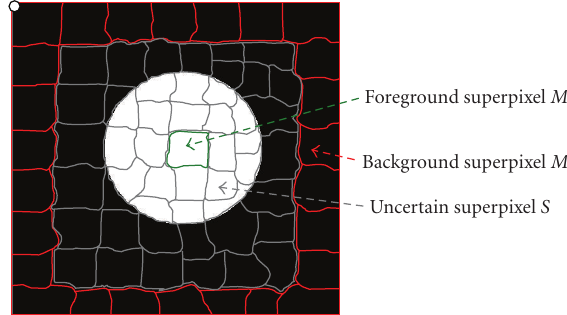
Figure 7: A example of an attached nodule segmentation using di ff erent pairwise smoothing energies. (a1–a3) 3D nodule in three contiguous slices in CT; (b1–b3) nodule segmentation using the first term only in (9); (c1–c3) results by using the second term only in (9); (d1–d3) nodule segmentation by using the complete energy defined in